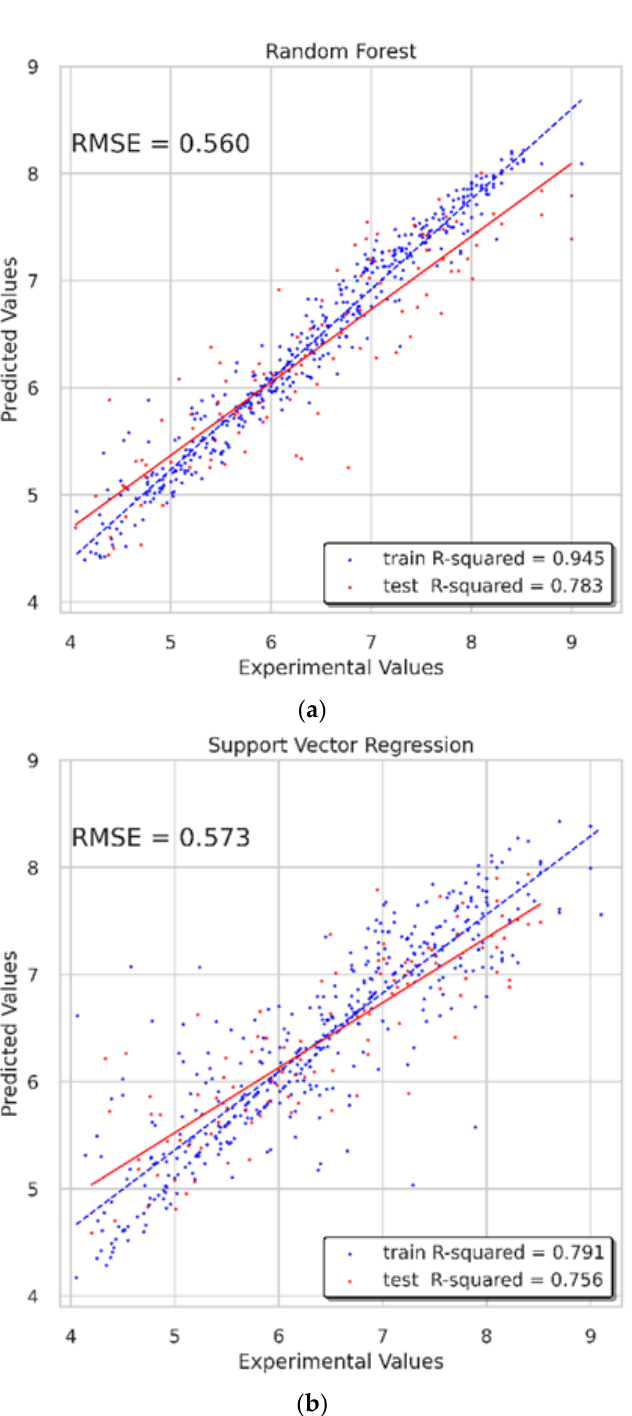
Figure 13. Results of traditional machine learning models. ( a ) Result of RF model; ( b ) Result of SVR model.